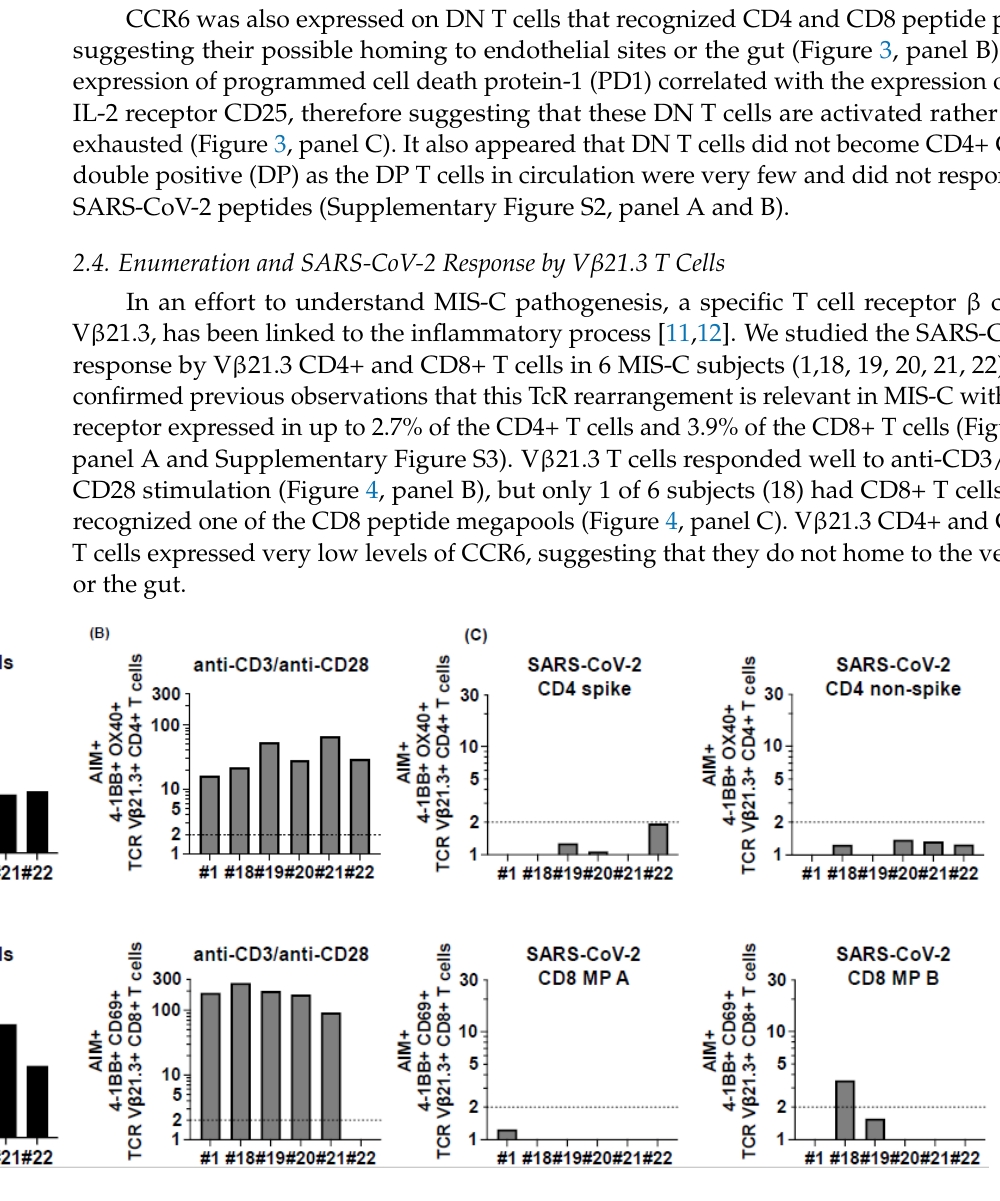
Figure 4. TCR V β 21.3+ CD4+ and CD8+ T cell responses to peptide megapools derived from SARS- CoV-2 in subacute MIS-C subjects. CD4+ and CD8+ T cells from 6 (1 and 18–22) of the 22 MIS-C subjects were studied for their TCR V β 21.3 usage and the TCR V β 21.3+ CD4+ and CD8+ T cell responses to SARS-CoV-2. ( A ) TCR V β 21.3 usage of CD4+ (top panel) and CD8+ (bottom panel) T cells under an unstimulated condition. An amount of 1.7%–2.7% of CD4+ cells and 1.9%–3.9% of CD8+ T cells were TCR V β 21.3+ among the 6 subjects studied. ( B ) TCR V β 21.3+ CD4+ (top panel) and CD8+ (bottom panel) T cell activations in response to anti-CD3/anti-CD28, SARS-CoV-2 CD4 spike and non-spike, and SARS-CoV-2 CD8 MP A and B peptide megapool stimulations. SIs of AIM+ TCR V β 21.3+ CD4+ and CD8+ T cells from each individual subject are shown. TCR V β 21.3+ CD4+ and CD8+ T cells from all the subjects responded to anti-CD3/anti-CD28 stimulation except for 1 subject. ( C ). The majority of the TCR V β 21.3+ CD4+ and CD8+ T cells showed no